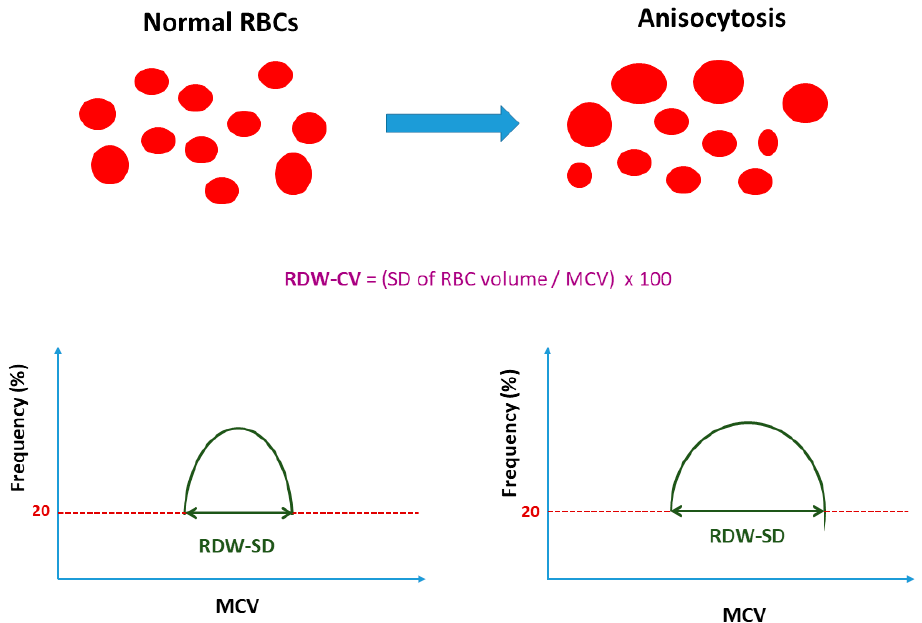
Figure 1. Definition and calculation of the red blood cell distribution width (RDW); in the case of anisocytosis, RDW increases. RDW-CV, coefficient of variation of erythrocyte volumes; RDW-SD, standard deviation of erythrocyte volumes; RBC, red blood cell; MCV, mean corpuscular volume.